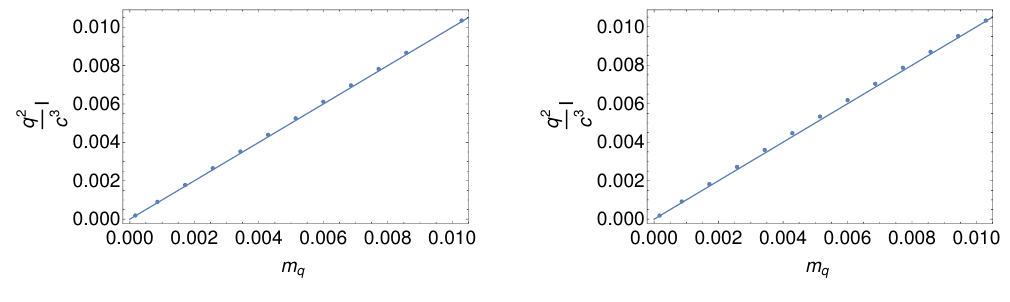
Figure 23 . Left panel is for c = − 2 , I = 0 . 061 and right corresponds to c = − 1 . 5 , I = 0 . 011